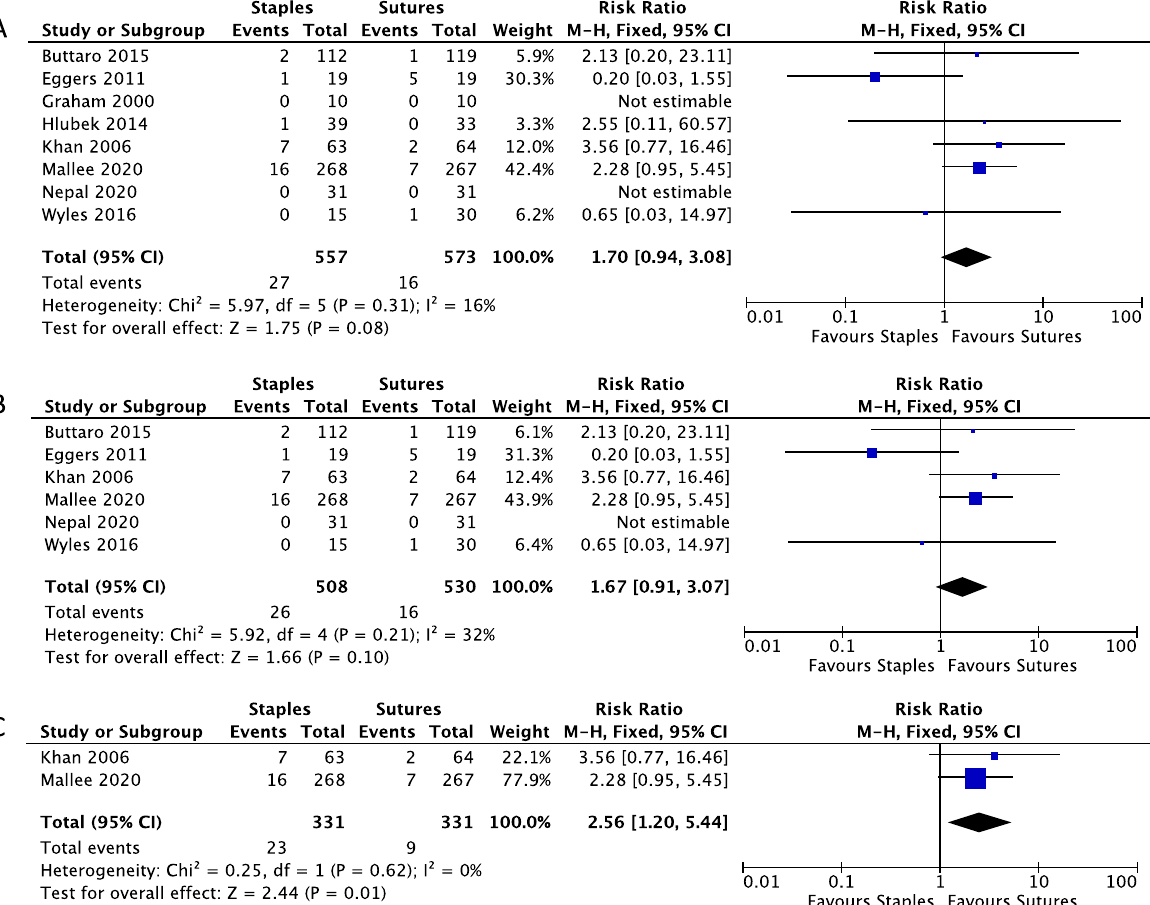
Fig. 2 Forest plot showing the relative risk (RR, 95% CI) for patients receiving staples versus sutures for wound closure in arthroplasty in ( A ) all included RCTs, ( B ) RCTs with some concerns and low risk of bias, and ( C ) RCTs with only low risk of